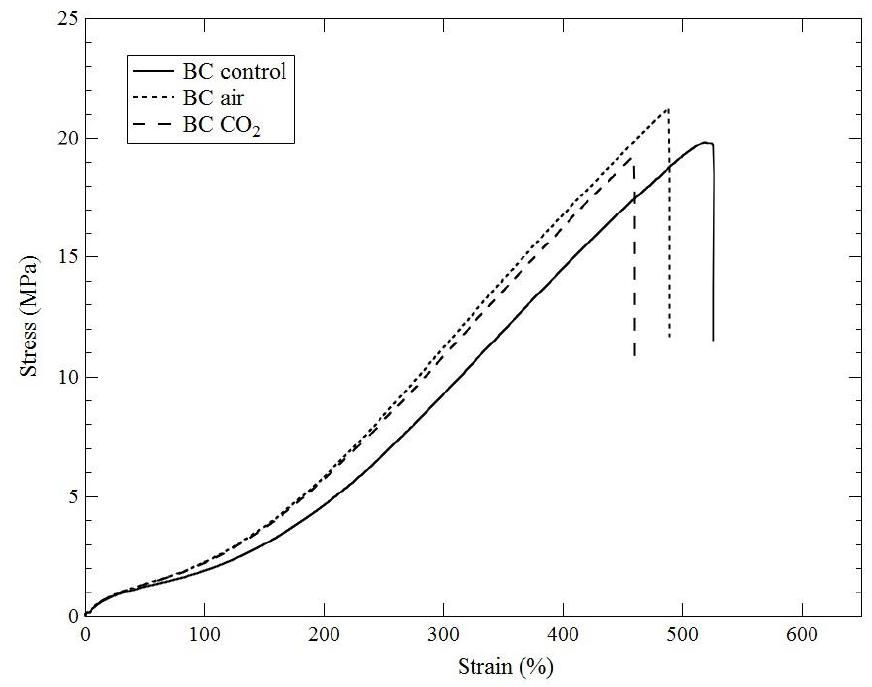
Figure 3. Stress vs. strain curve for the three uncoated biochar samples, illustrating the effect of air and CO 2 treatment during biochar processing.